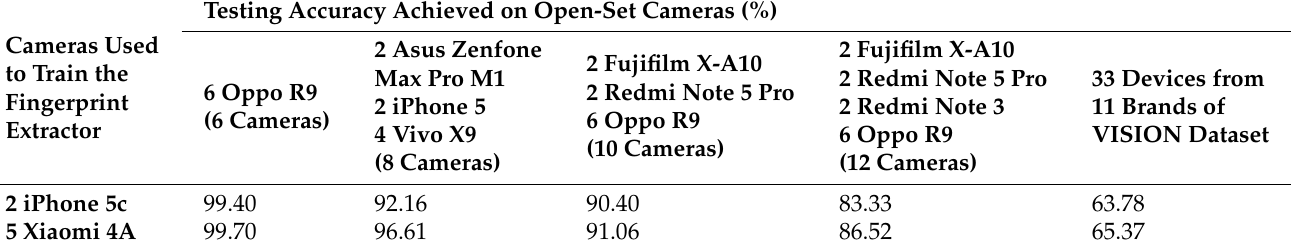
Table 4. Performance of the new device-specific fingerprint in the open-set